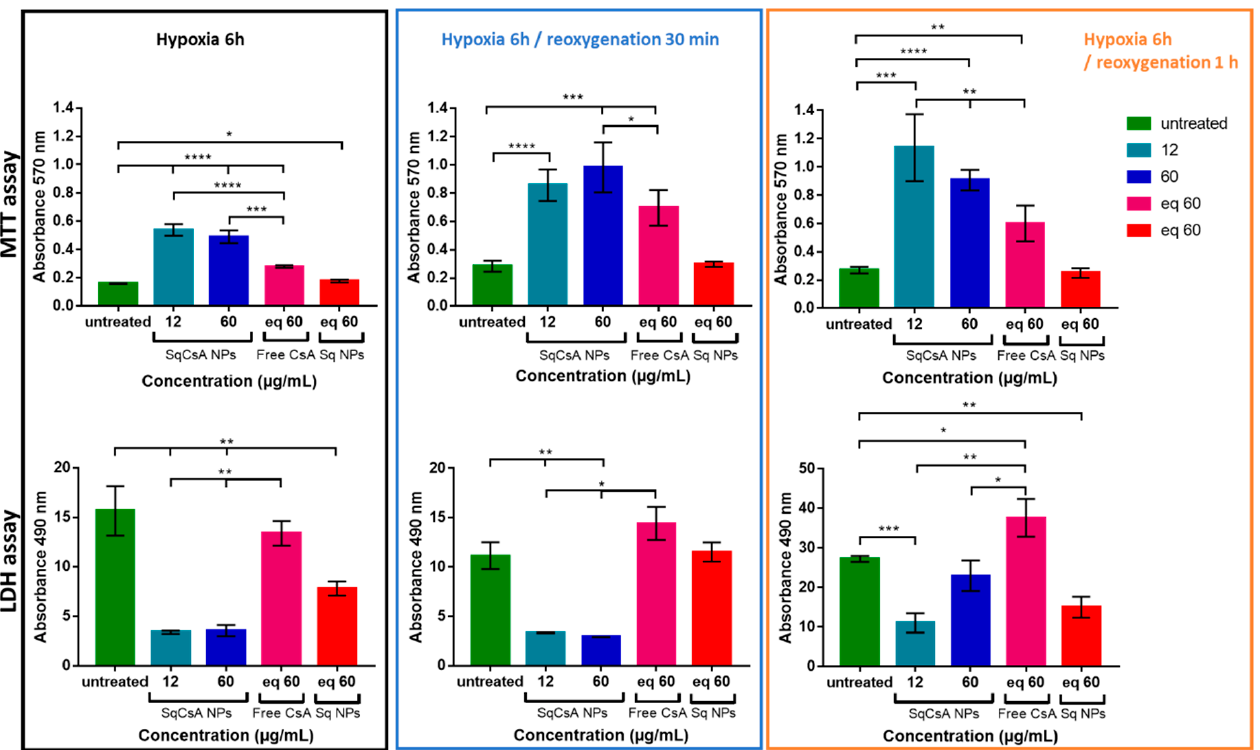
Figure 8. Cardioprotective effect assessment on H9c2 cell line. Cells were incubated with SqCsA NPs for 24 h. Controls (untreated cells, free CsA, or Sq NPs) were done under the same conditions. After incubation time, cells were rinsed with Phosphate-Buffered Saline (PBS) and incubated in hypoxic condition (1% O 2 and restraint medium without fetal bovine serum (FBS) and glucose). Cardioprotection was assessed by using thiazolyl blue tetrazolium bromide (MTT) test (upper panel) and lactate dehydrogenase (LDH) test (lower panel). For the MTT tests, the higher the percentage, the more viable the cells. For the LDH tests, the higher the percentage of LDH-released protein, the more damaged the cells. * p ≤ 0.05, ** p ≤ 0.01, *** p ≤ 0.001, **** p ≤ 0.0001.